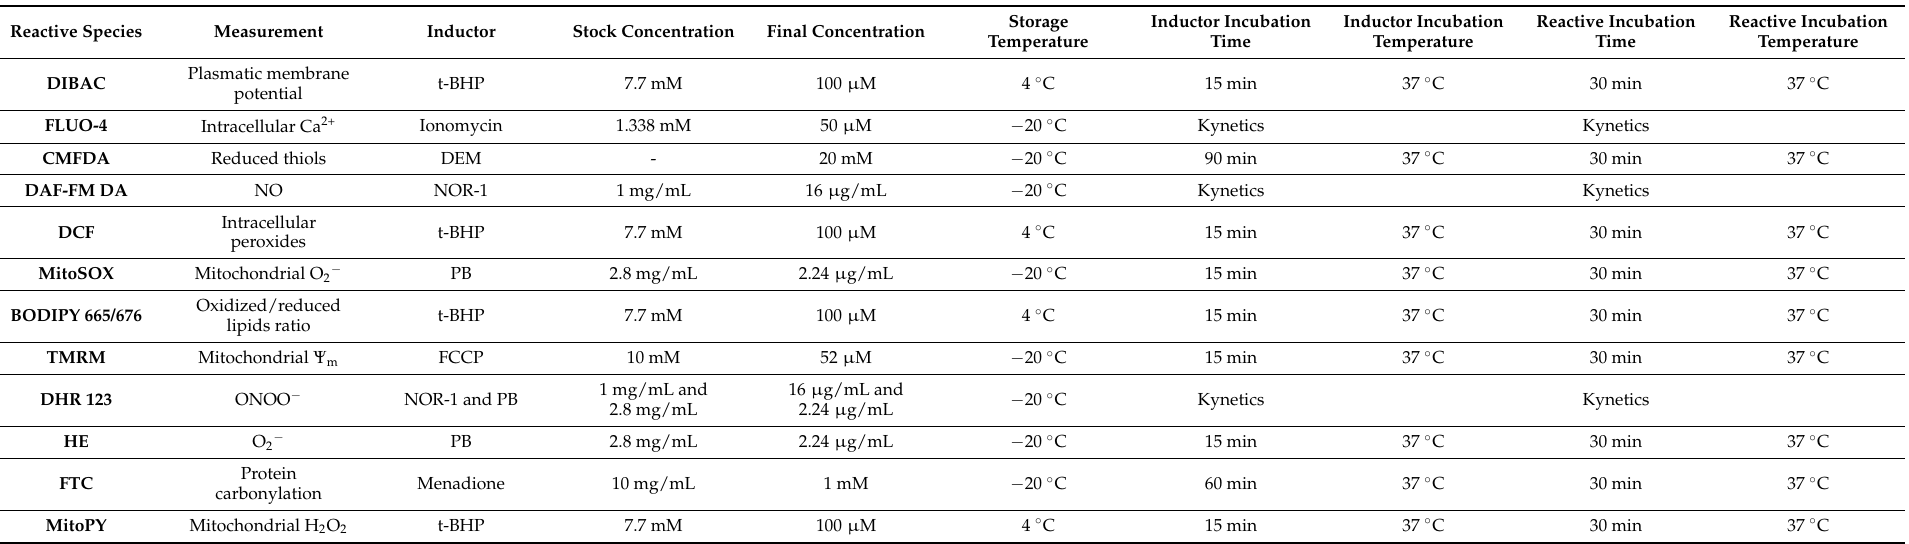
Table 2. Summary of cytometry methods for positive